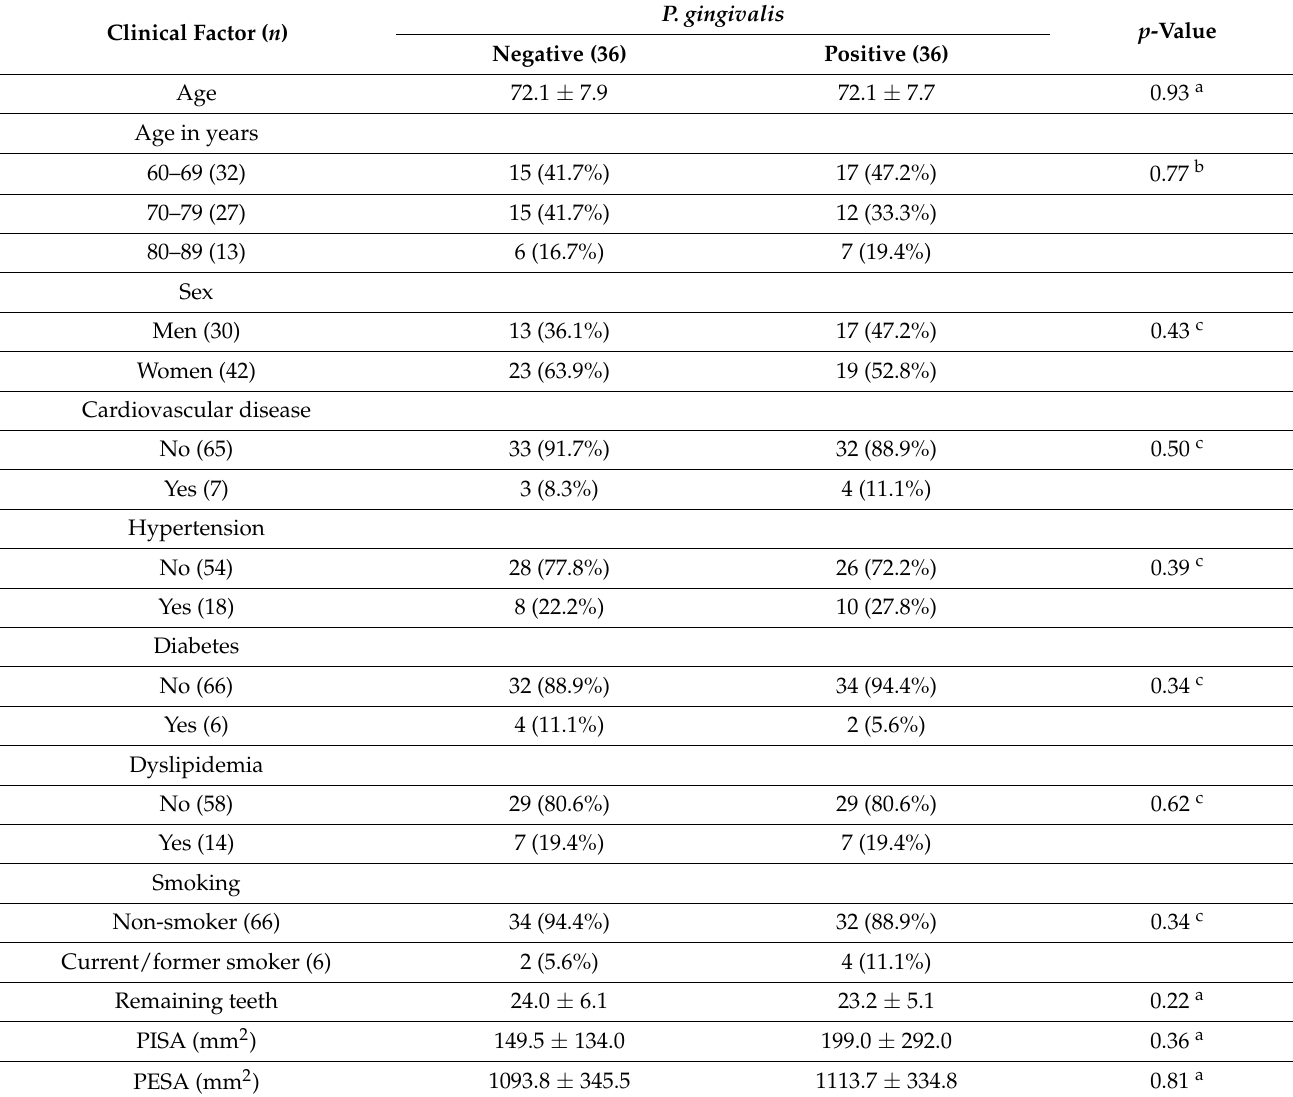
Table 3. Associations of P. gingivalis presence with PISA and PESA in 72 propensity score-matched patients. Clinical Factor ( n )